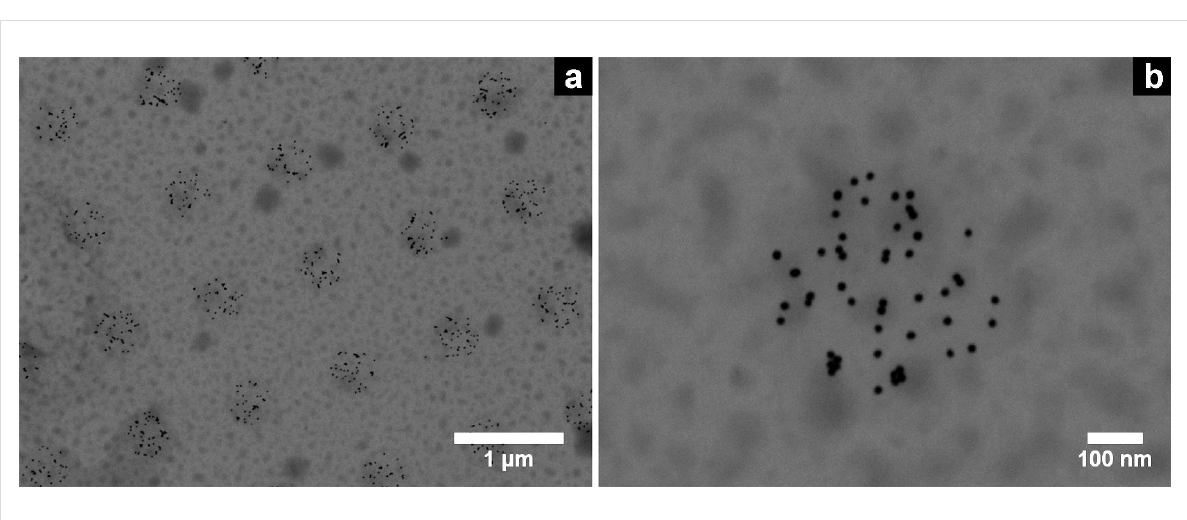
Figure 3: SEM-T micrographs of CSPETCS silanised SiO 2 TEM windows after irradiation and incubation with a solution of citrate-stabilised 16 nm AuNPs. The intended and the actual spot diameters are 400 nm and 400 ± 20 nm,